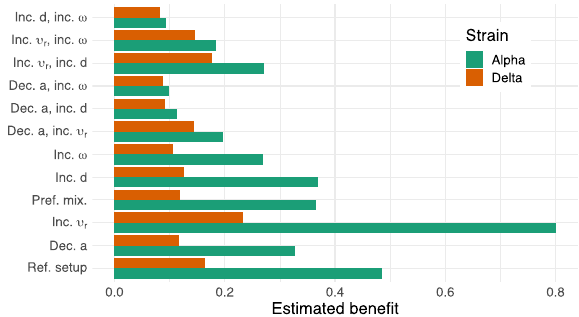
Fig. 5 The estimated bene fi t of vaccination passes (VPs). For each parameter setting (reference setup and single or double parameter value changes to it; y axis), the bene fi t of VPs was evaluated ( x axis) for two SARS-CoV-2 strains: Alpha (green) and Delta